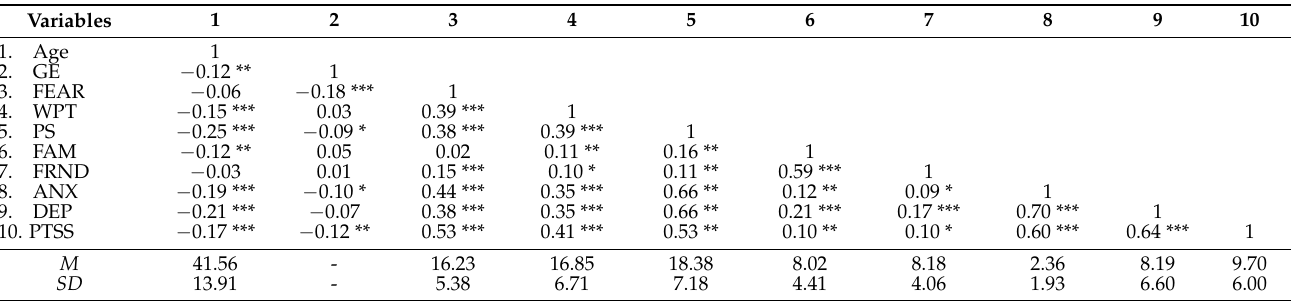
Table 2. Means, standard deviations, and bivariate correlations ( n = 842).